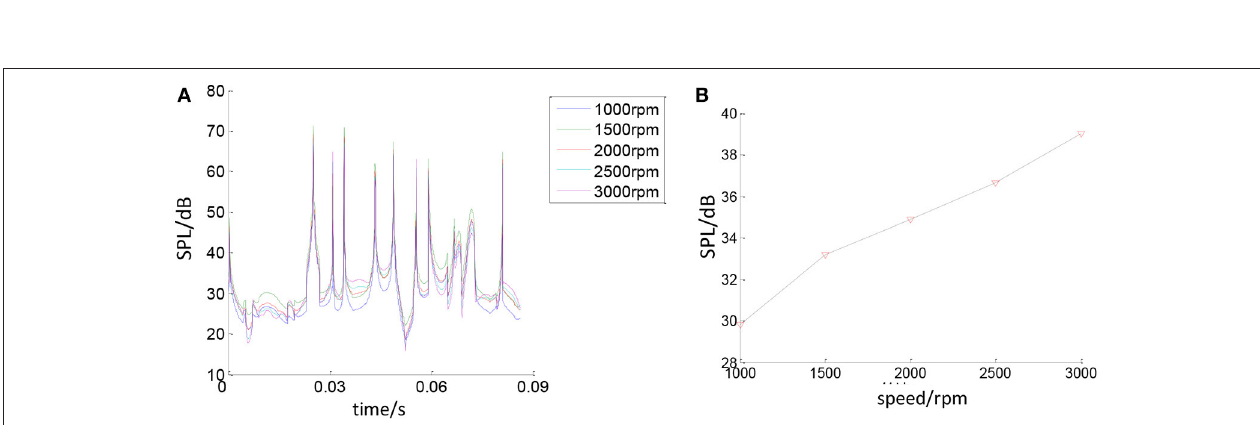
FIGURE 17 | The relationship between the amplitude of the waviness and the sound pressure. (A) Effect of waviness amplitude on SPL. (B) Effect of waviness amplitude on average SPL.